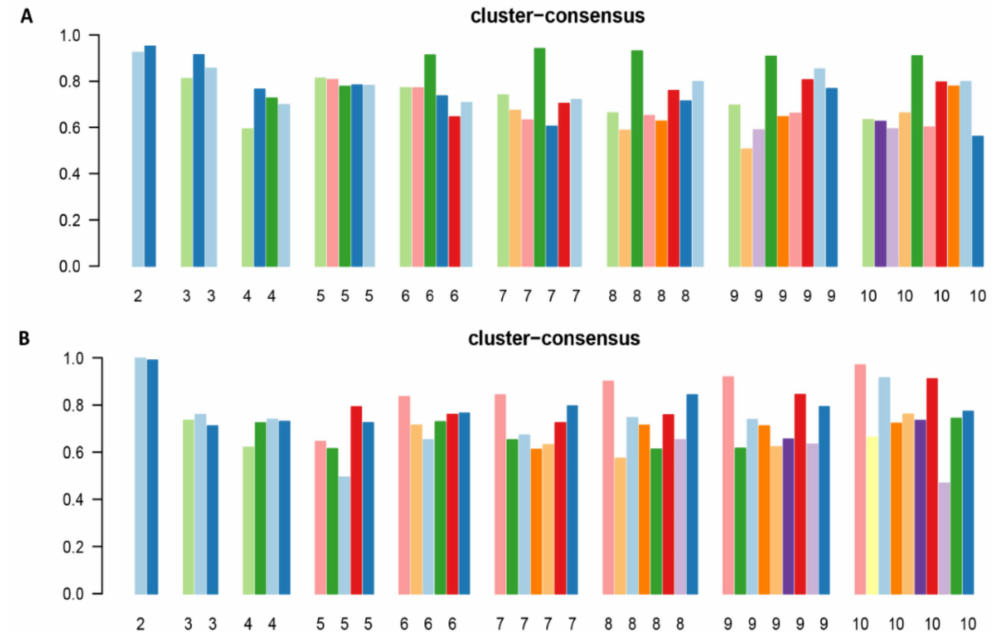
Figure 2. ( A ) Bar plots representing the mean consensus score for hypophosphatemic patients per different numbers of clusters (ranging from 2 to 10); ( B ) Bar plots representing the mean consensus score for hyperphosphatemic patients per different numbers of clusters (ranging from 2 to